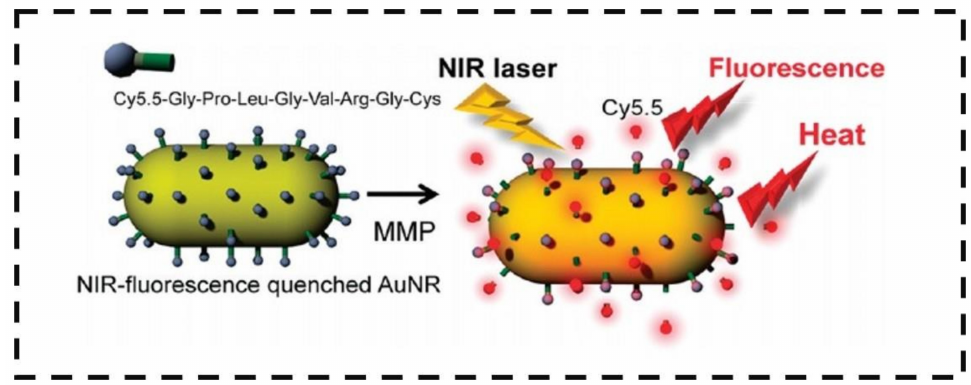
Figure 1. Schematic diagram of MMP-functionalized AuNRs for simultaneous imaging and pho- tothermal therapy. Adapted with permission from Ref. [22]. 2010, American Chemical